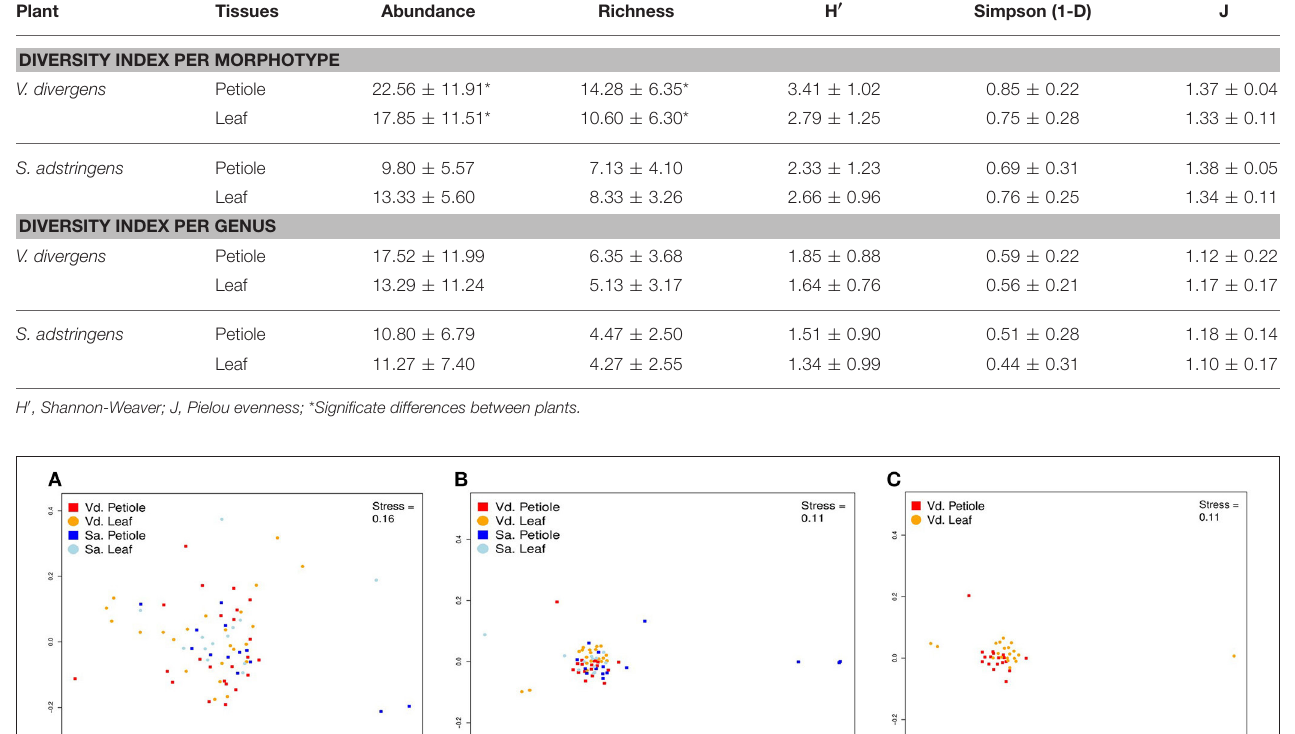
TABLE 2 | Diversity index and descriptive data for morphotypes and genus analyzed. Plant Tissues Abundance Richness H ′ Simpson (1-D) J